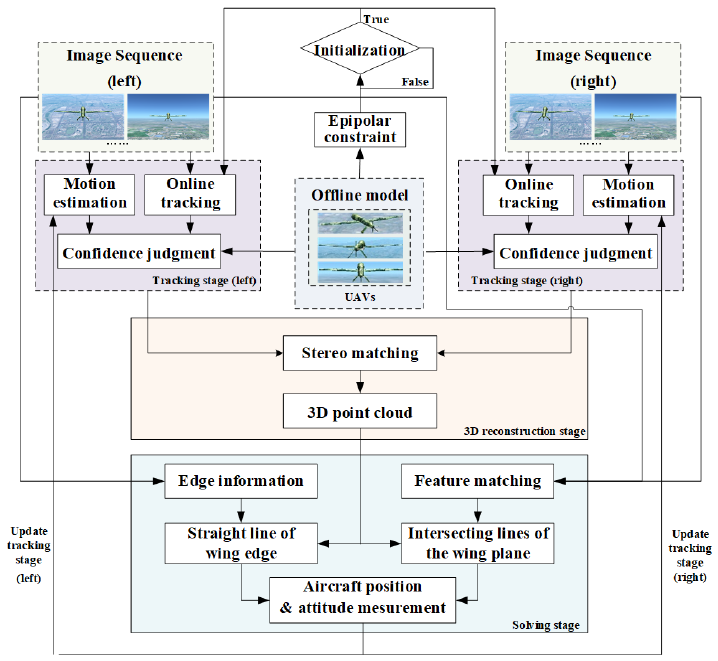
Figure 3. Framework of the proposed